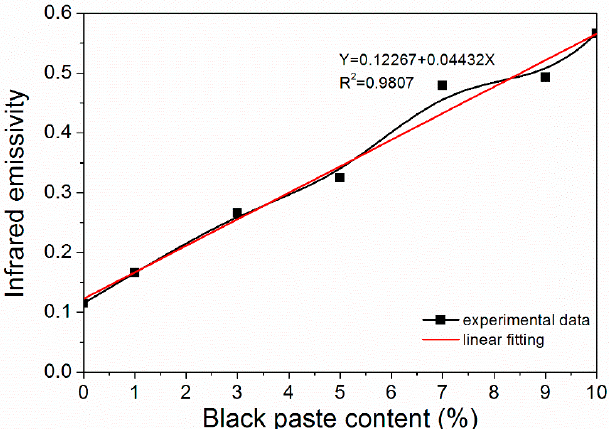
Figure 3. Effect of black paste content on the infrared emissivity of the coatings.